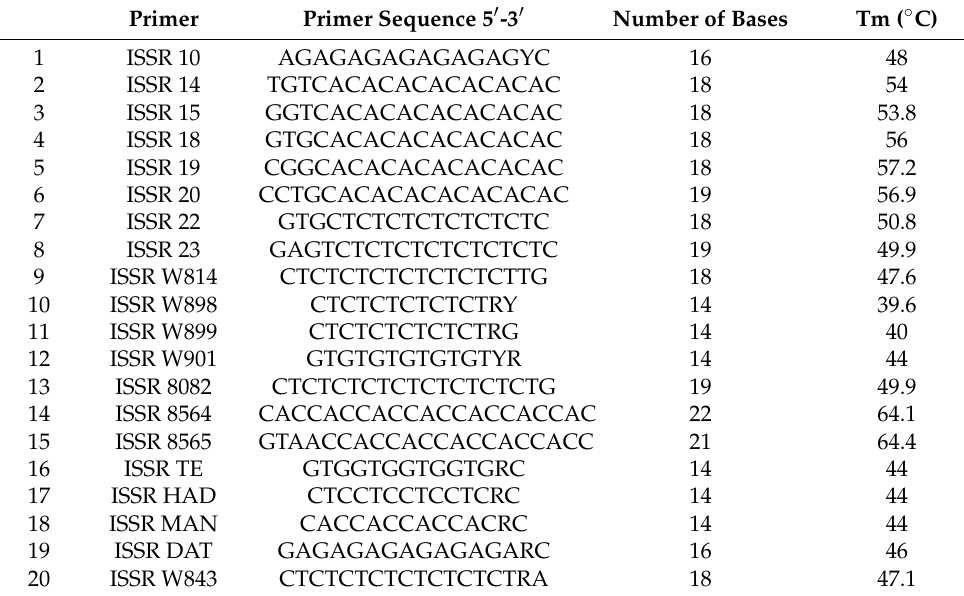
Table 3. Details of the twenty primers used and melting temperatures